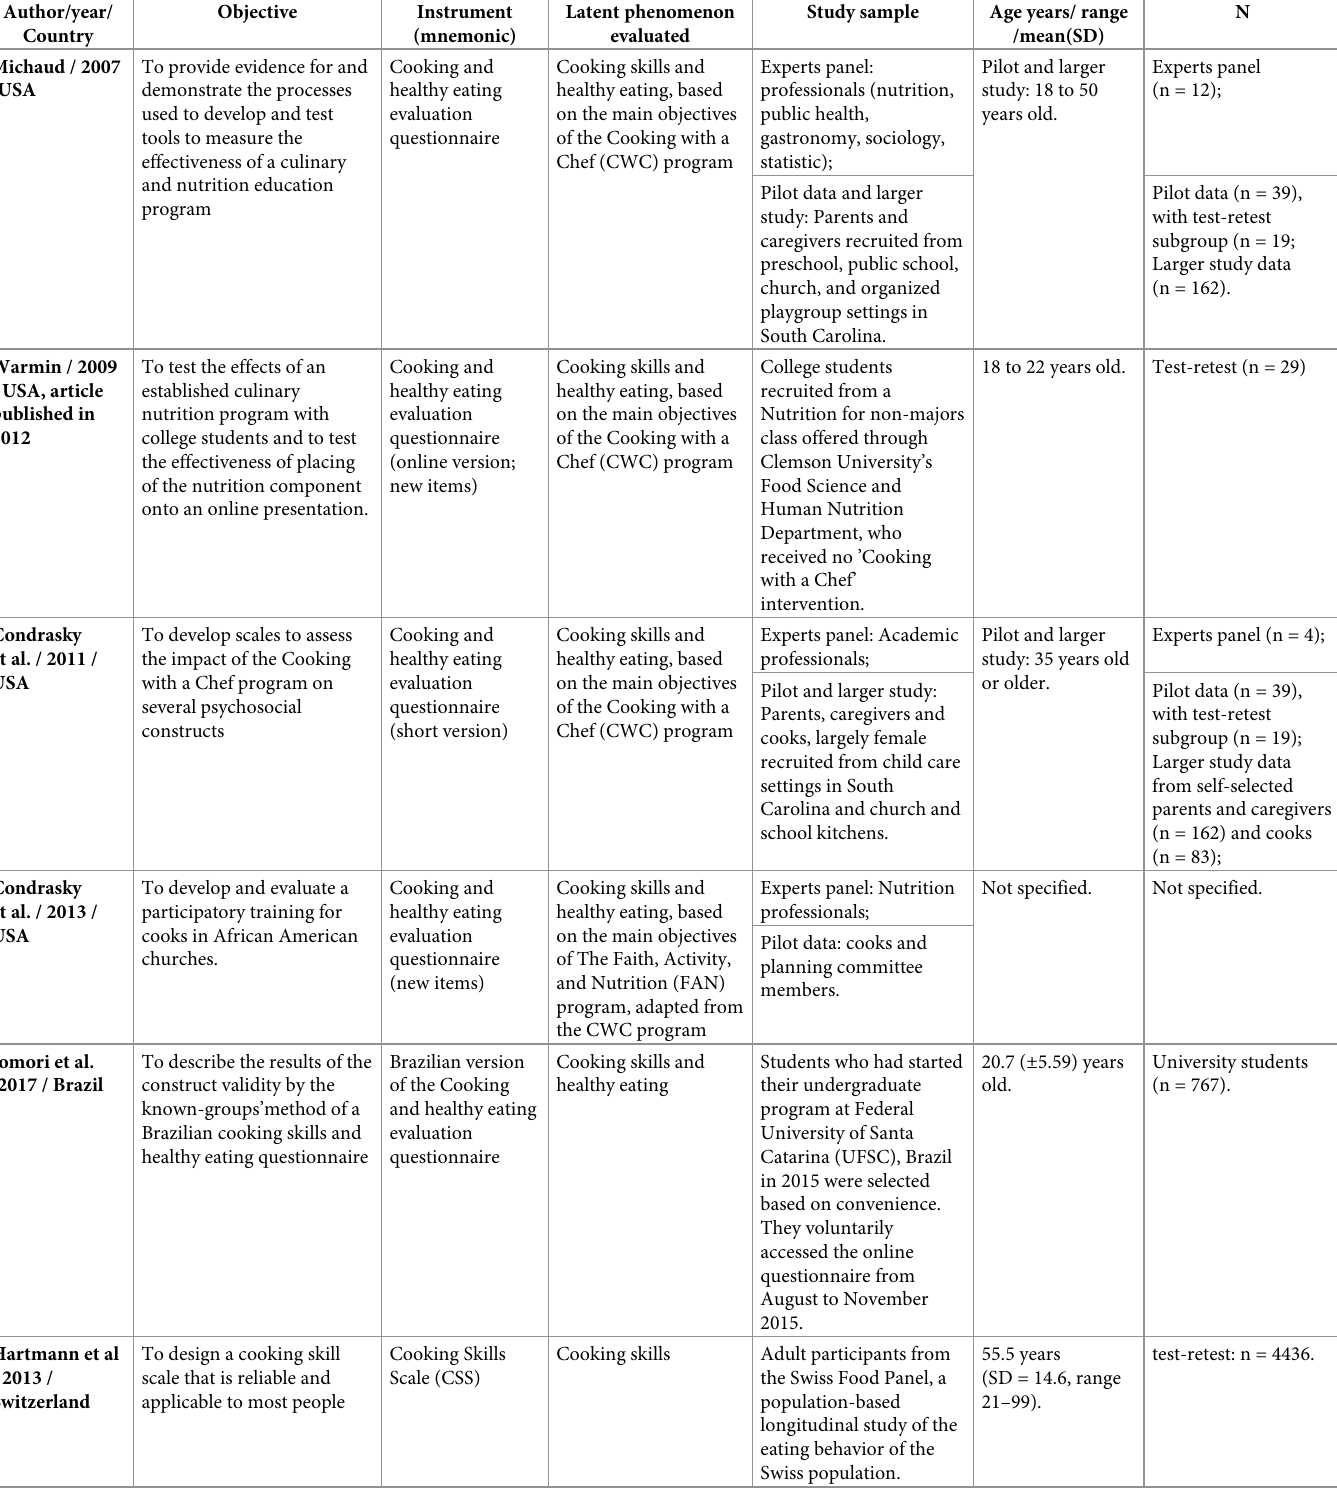
Table 2. Characteristics of the included